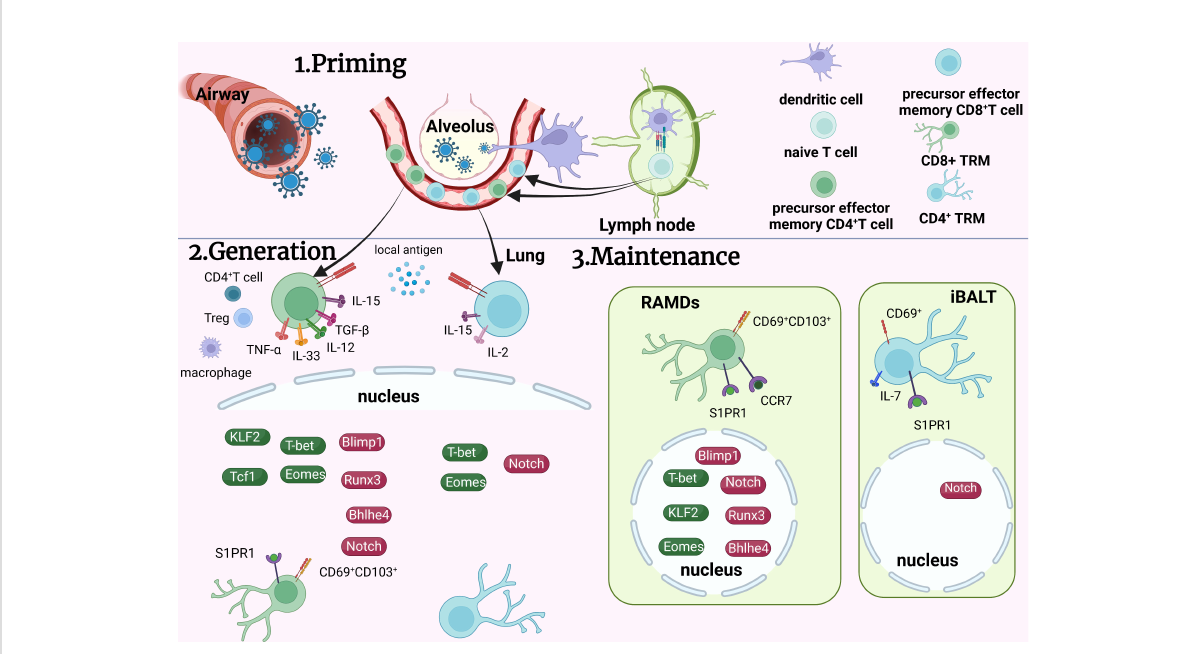
FIGURE 2 Development of TRM cells in the lung. On contact with the virus, speci fi c dendritic cells migrate to lymph nodes to communicate with naïve T cells and activate the generation of effector T cells. Some effector T cells migrate to the lungs and transform into TRM cells by various signaling pathways. CD8 + TRM cells accumulate in RAMDs and CD4 + TRM cells accumulate in iBALs after formation. To maintain TRM cells in the lungs, many transcription factors coordinate with each other to achieve overall functionality. TRM, tissue resident memory T cells; RAMDs, repair associated memory depot; iBALs, inducible bronchus associated lymphoid tissue; APC, antigen presenting cells; Green icons, inhibitory roles; red icons, facilitating